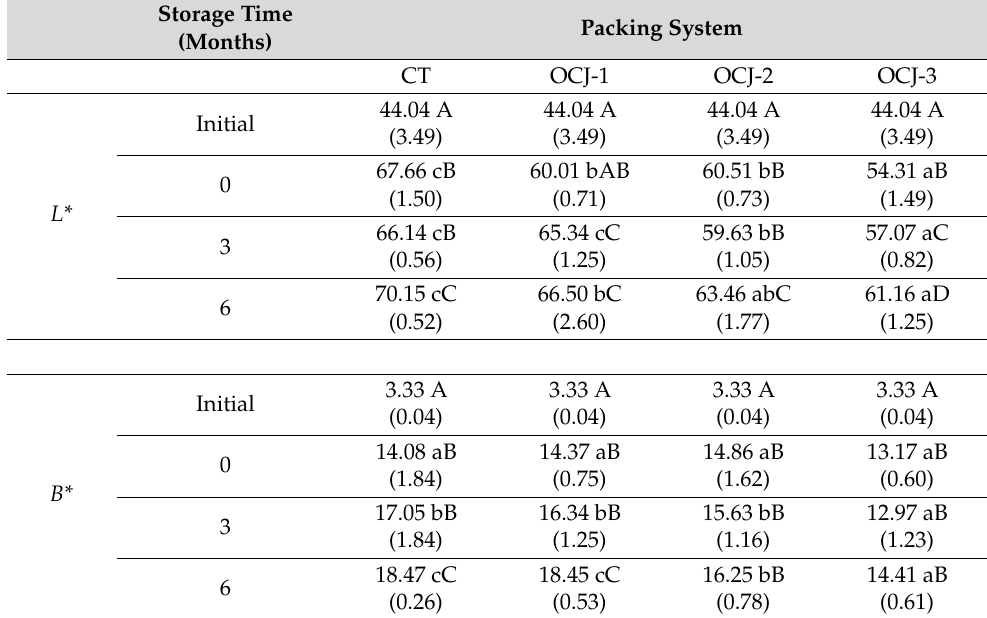
Table 3. Determination * of colour values in initial and canned horse mackerel previously subjected to frozen storage and canned with different packing systems